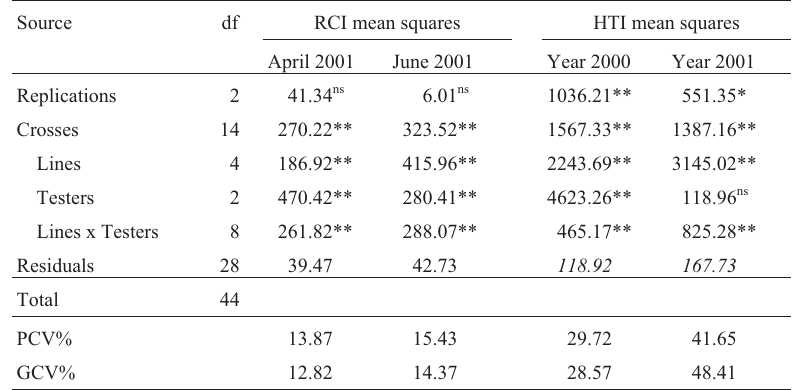
Table 3 - Mean squares from the analyses of variance of combining ability in crosses of upland cotton for cellular membrane thermostability (CMT) as measured by relative cell injury (RCI) in April and June temperature regimes and heat tolerance index (HTI) in 2000 and 2001 crop years. Source df